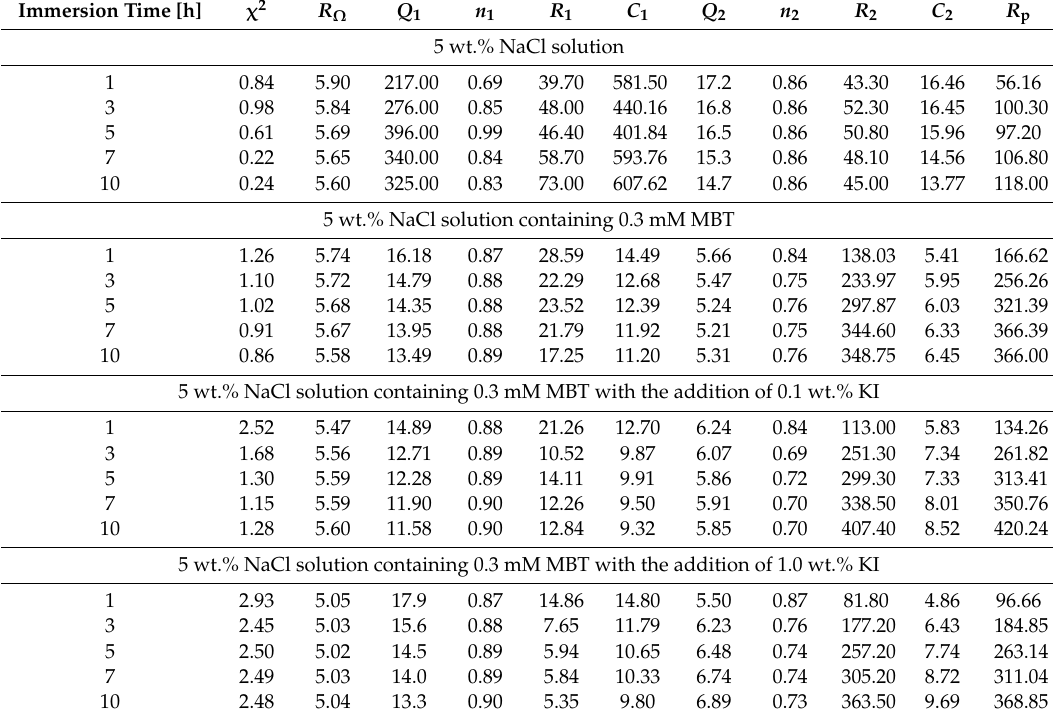
Table 2. The parameters obtained from fitting the EIS response of the AA6082 aluminium alloy samples immersed in 5 wt.% NaCl solution containing 0.3 mM MBT or a combination of 0.3 mM MBT and 0.1 wt.% KI, after 1–10 h of immersion, at 25 ◦ C. In addition, the fitted parameters from the EIS spectra of the AA6082 aluminium samples in 5 wt.% NaCl solution, previously reported in [15], are given for comparison. Units: χ 2 [ × 10 − 3 ], R Ω [ Ω cm 2 ], R 1 , R 2 , and R p [k Ω cm 2 ], Q 1 and Q 2 [ µ Ω − 1 cm − 2 s n ], and C 1 and C 2 [ µ F cm − 2